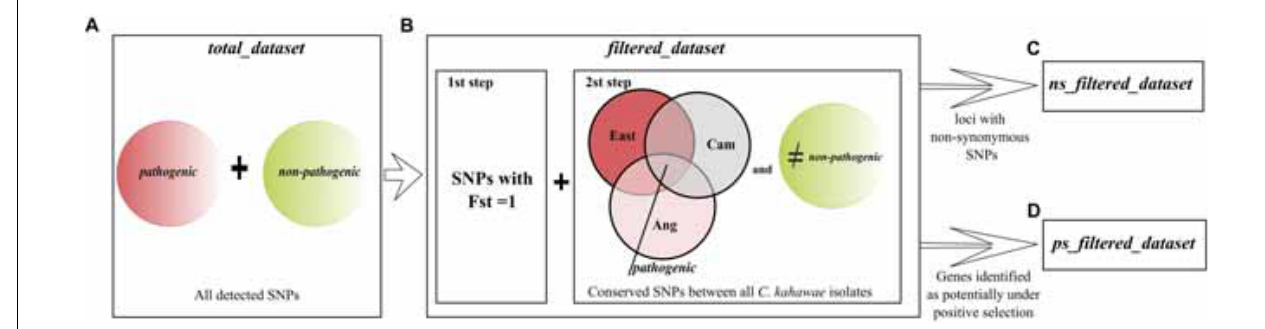
FIGURE 1 | Schematic representation of the datasets used for the analyses conducted in this study. (A) total_dataset comprising all the detected SNPs; (B) filtered_dataset comprising the diagnostic SNPs between pathogenic and non-pathogenic groups. The three Colletotrichum kahawae populations were named as Ang (Angolan), Cam (Cameroonian), and East (East African). (C) ns_filtered_dataset comprising all the loci with non-synonymous SNPs within the diagnostic SNPs; (D) ps_filtered_dataset comprising all the genes potentially under positive selection.